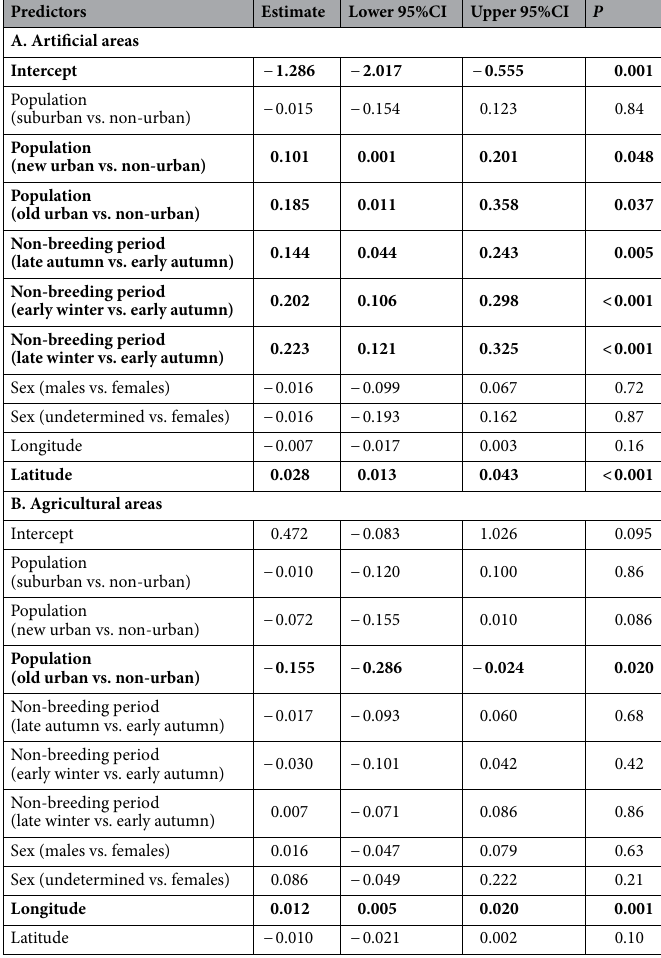
Table 1. The results of general linear mixed models assessing variation in the share of artificial (A) and agricultural (B) areas in non-breeding habitats (0.5 km scale) selected by Eurasian coots from different breeding populations in central Poland. Year and individual identity were entered as random factors in each model. Marginal/conditional R 2 for each model were 0.28/0.48 (A) and 0.15/0.44 (B), while ΔAIC was 26.0 (A) and 3.4 (B). Significant predictors are marked in